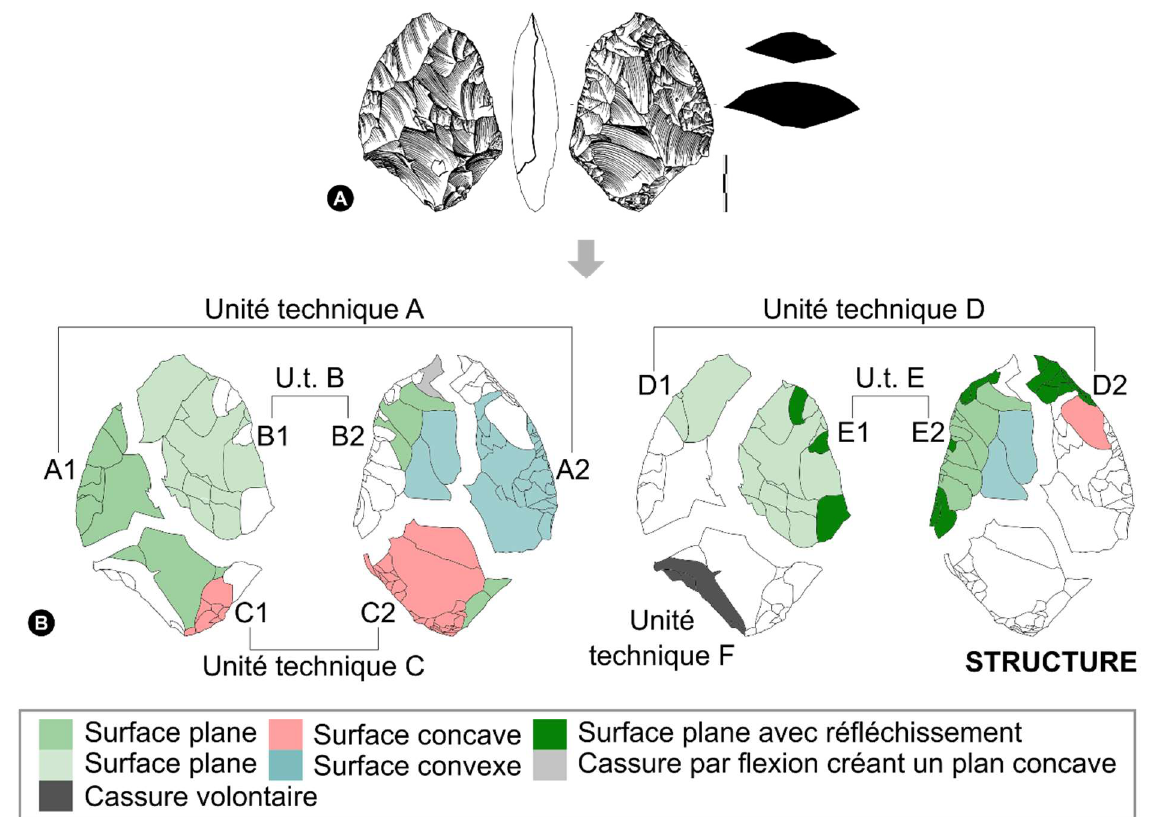
Figure 9. Exemple d'analyse technicofonctionnelle d'une pièce bifaciale proventant de la couche C’3 base du site de Barbas I, Dordogne (Boëda 2001: 63, figures 8 et 9): (A) dessin de la pièce, (B) détermination des unités technico-fonctionnelles qui définissent la structure tripartite de la pièce bifaciale. Ultérieument, au niveau interprétatif, cette détermination structurelle permettra de définir le stade évolutive (abstraite ou concrète) auquel appartient la